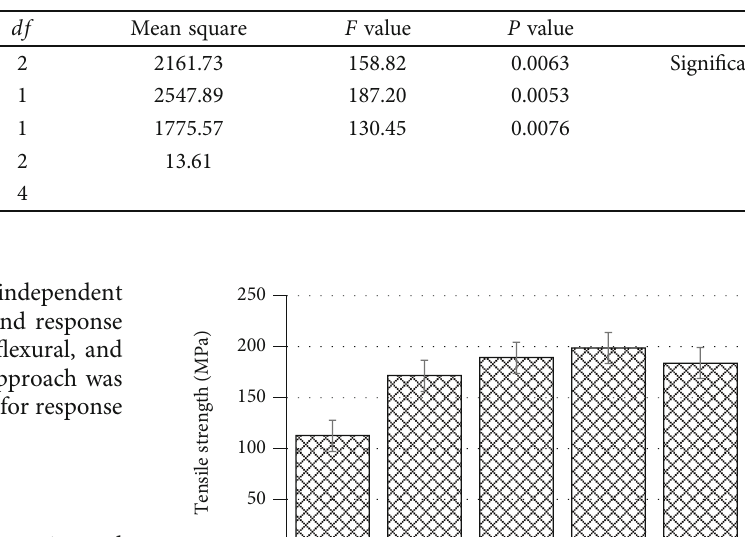
Figure 2: Composite thickness. Table 2: ANOVA quadratic model for tensile strength.